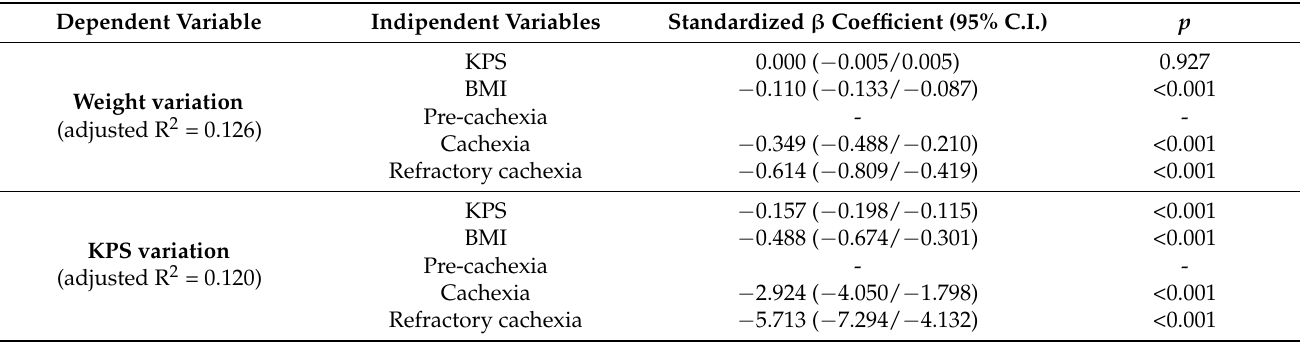
Table 3. Association between weight and KPS variation after 1 month (dependent variables) and patient condition at the entry (KPS, BMI, cachexia, independent variables) in patients surviving more than 6 weeks. The analysis was performed by a general linear model adjusted for age and gender. Patients with pre-cachexia are considered as a reference for the regression analysis.